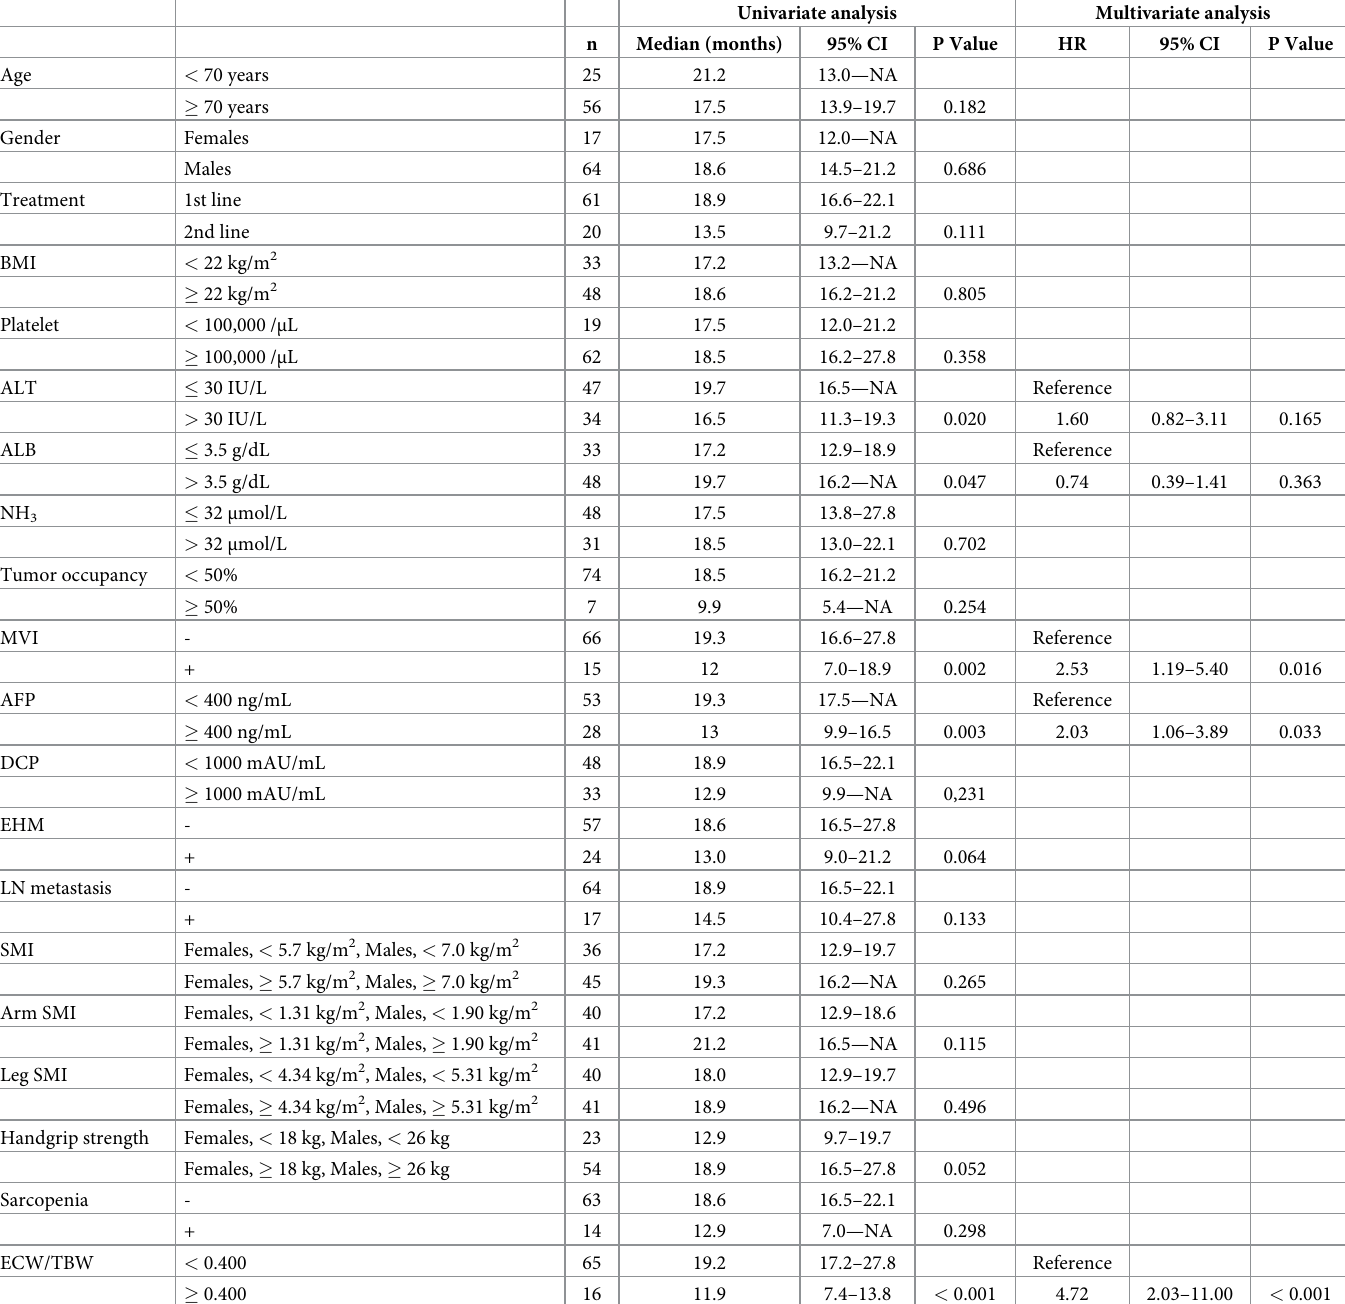
Table 2. Factors associated with overall survival treated with